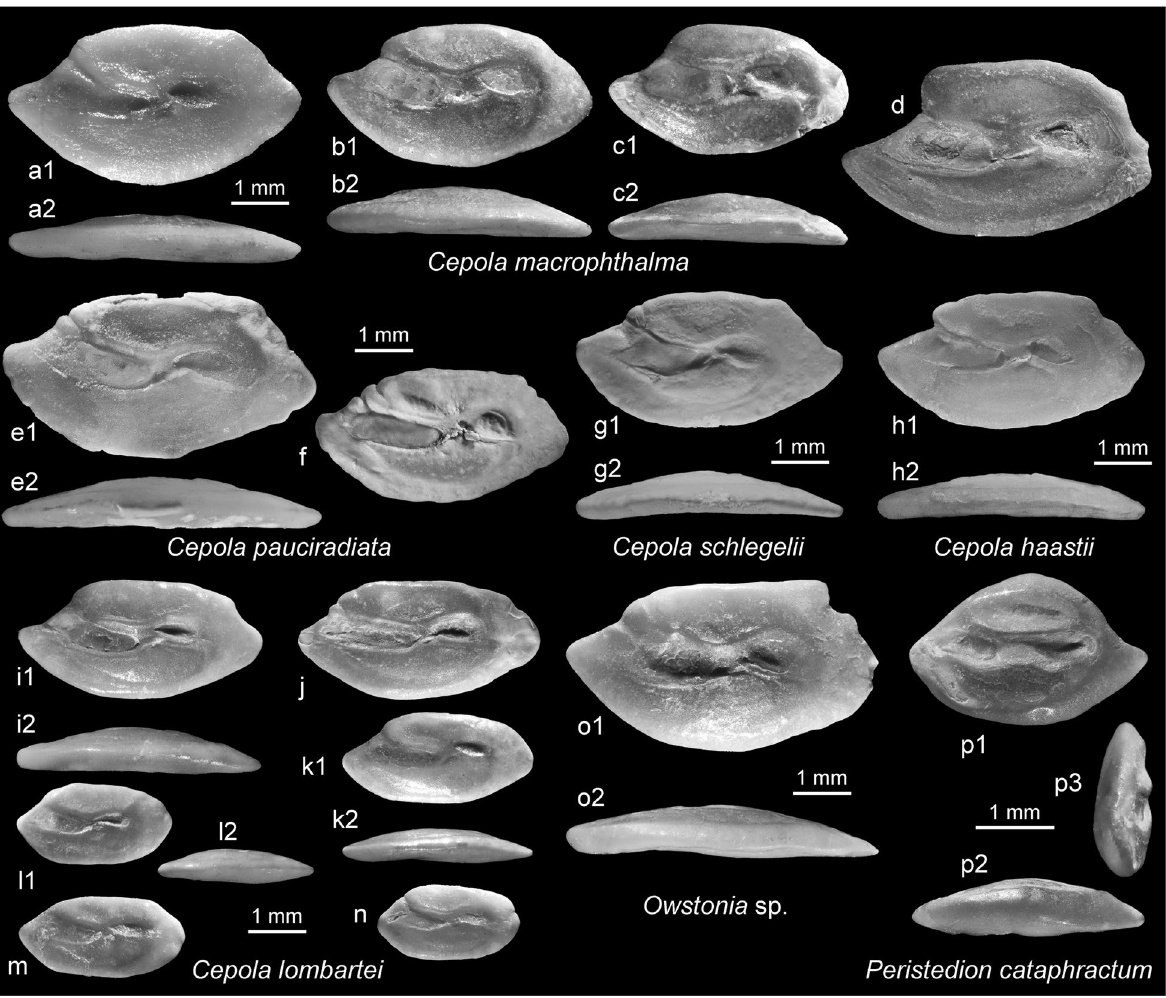
Fig. 24 Cepolidae and Triglidae. a – d Cepola macrophthalma (Linnaeus, 1758), a extant, southwestern France (reversed), b – d Dar bel Hamri, Zanclean, SMF PO 101.247. e – f Cepola pauciradiata Cadenat, 1950, extant, e , CAS 235490, 14°11’N, 17°22’W, f refigured from Schwarzhans (2013a), dredge in the Gulf of Guinea, 04°39’N, 01°08’W. g , Cepola schlegelii Bleeker, 1854, NSMT 110130, Taiwan. h Cepola haastii (Hector, 1881), New Zealand (reversed). i – n Cepola lombartei n. sp., Dar bel Hamri, Zanclean, i holotype, SMF PO 101.245, j – n paratypes, SMF PO 101.246. o Owstonia sp. SMF PO 101.248, Dar bel Hamri. p Peristedion cataphractum (Linnaeus, 1758), SMF PO 101.249, Dar bel